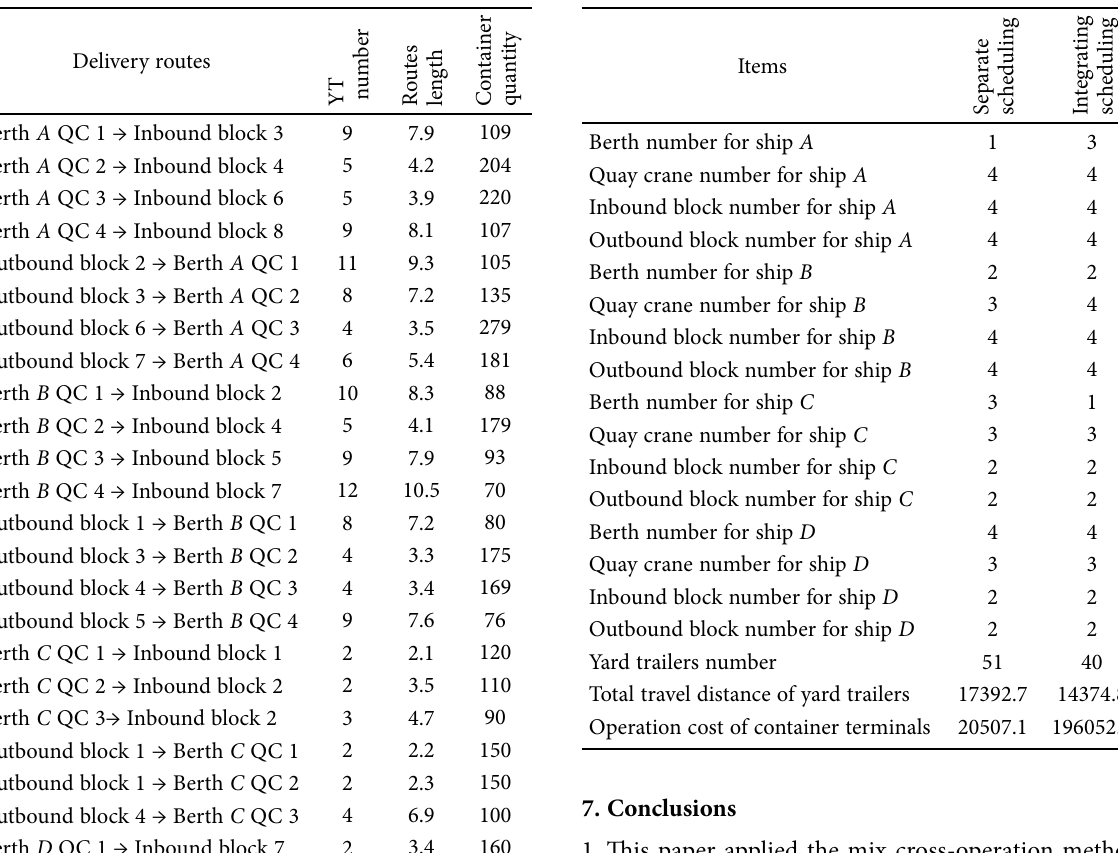
Table 3. Configuration and routing of YTs for loading and unloading separate-operations